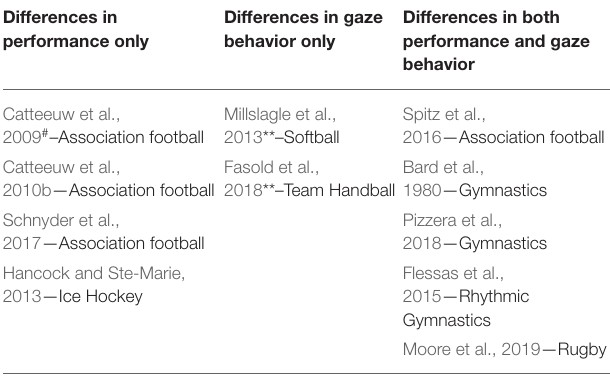
TABLE 3 | Studies that reported differences between referees with different skill levels in performance, gaze behavior, or both ( n = 11) *